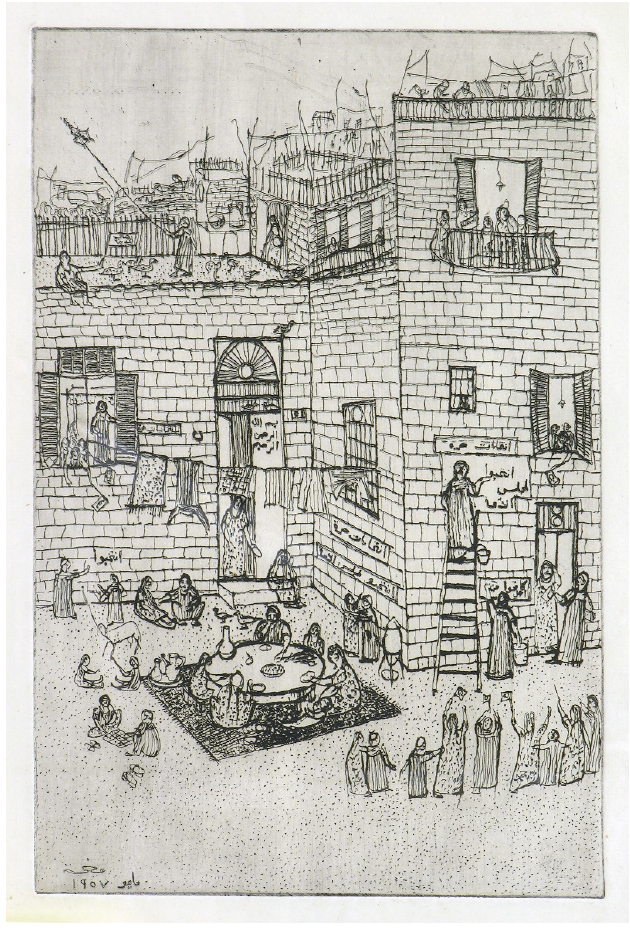
Figure 5. Menhat Helmy, The Elections (1957). Etching. Courtesy of estate of Menhat Helmy. In 1958, it appears a directed campaign by these women toward women’s health was being raised. As a deliberate strategy, Egyptian women were not going to rest and be content merely with the right of suffrage, but they now openly advocated public health, and particularly the need for women’s clinics. A current exhibition at the Barjeel